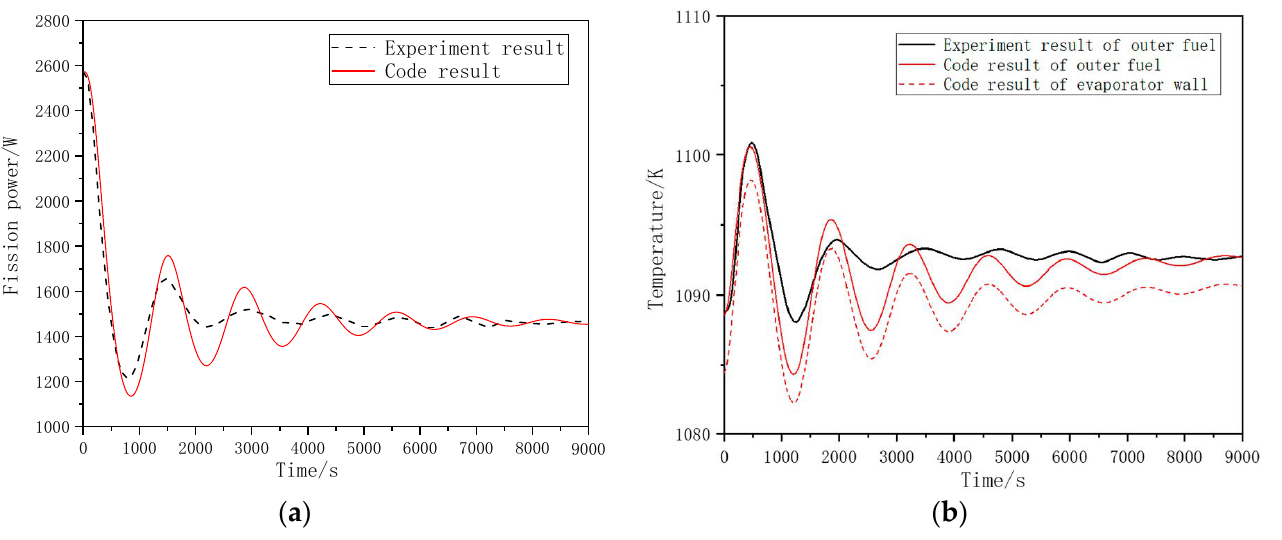
Figure 18. Core power and temperature for the loss of heat sink accident: ( a ) core power and ( b ) temperature.